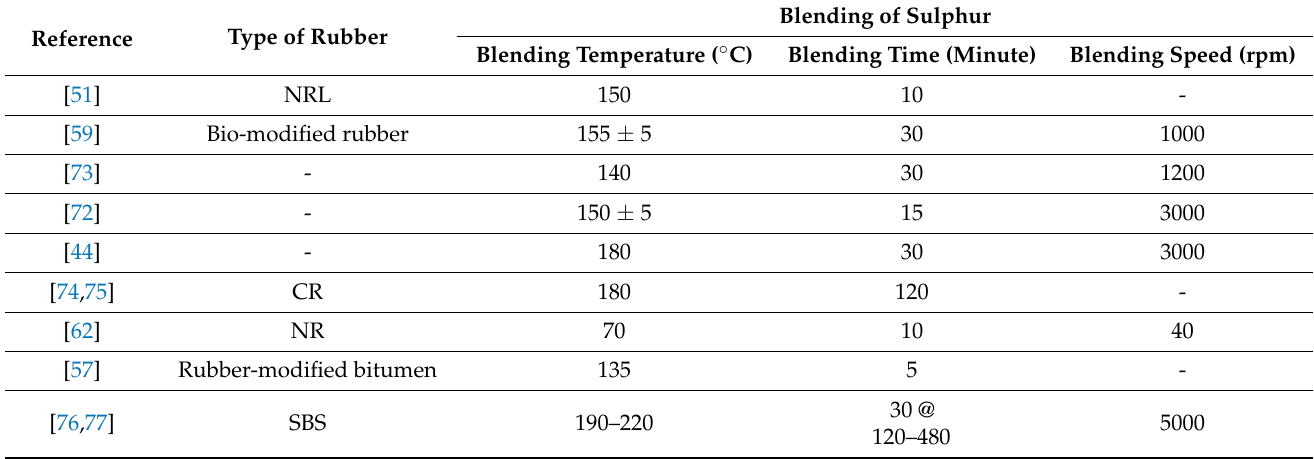
Table 14. Sulphur application based on previous studies.